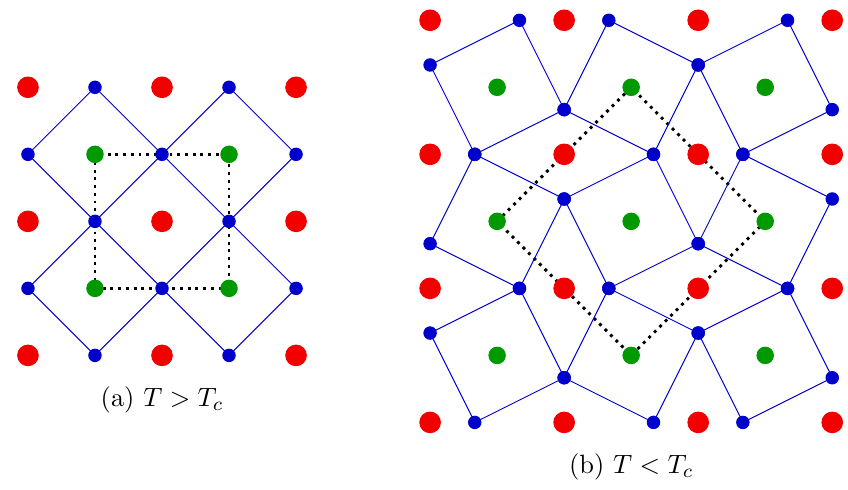
Figure 9 . The crystal structure in a top-down view above (a) and below (b) the critical transition temperature T c (cid:25) 100 K. The unit cell is highlighted by the dotted